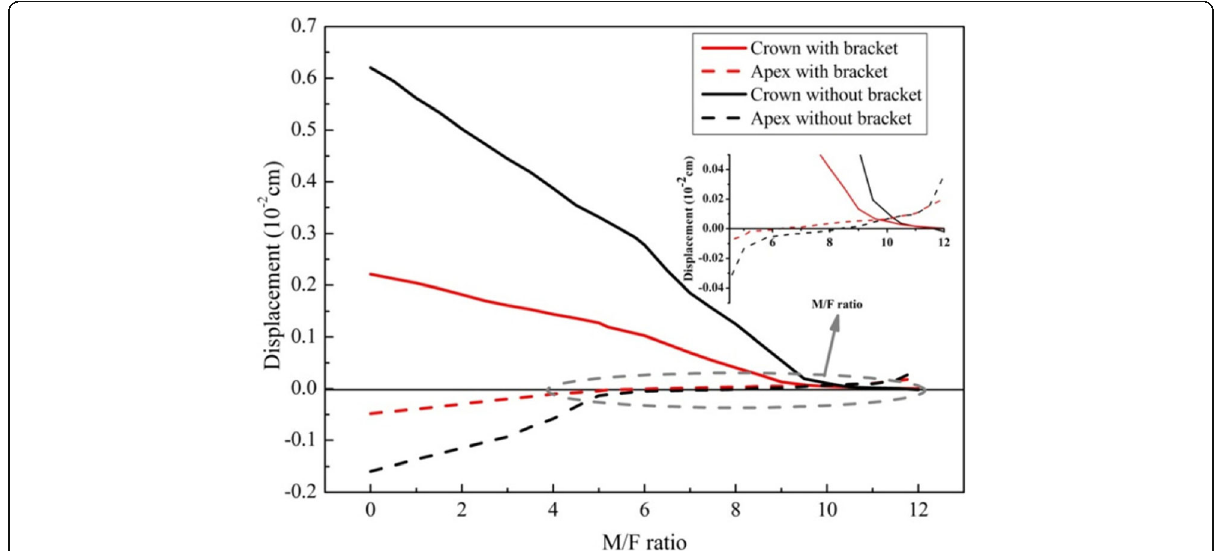
Fig. 5 Distal-mesial displacements of the crowns and apices of the mandible canine, a force of 100cN and the values of M/F ratio is increased from 1 to